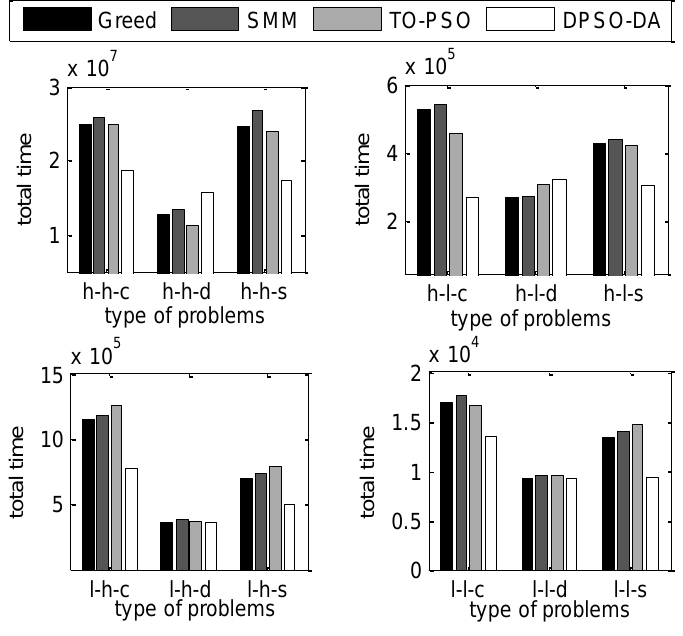
Figure 6. The total execution time under different task allocation solutions.